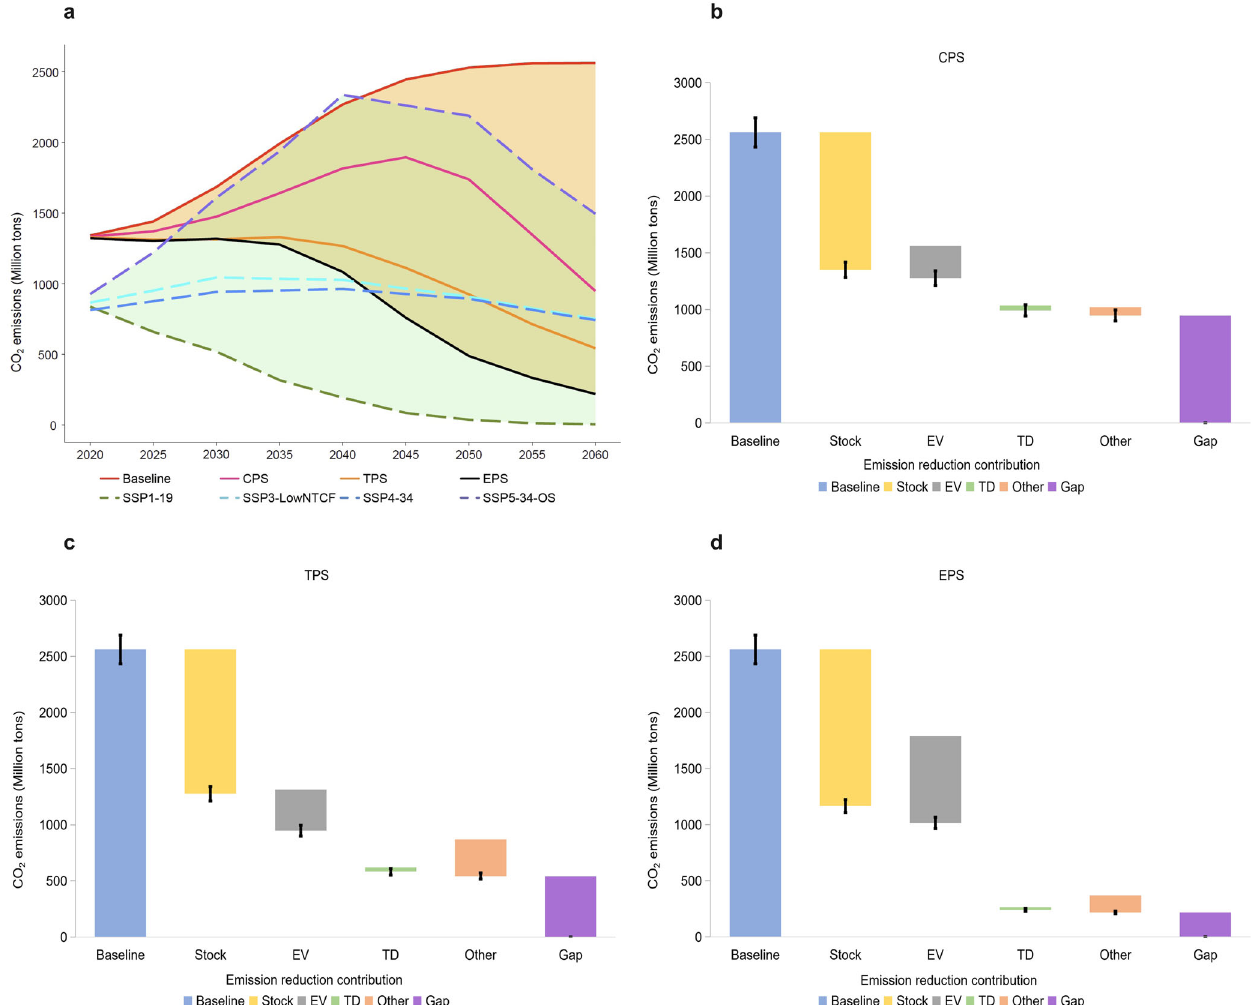
Fig. 5 CO 2 emissions pathways (2020 – 2060) and distribution of carbon mitigation contribution (2060) for China ’ s road transportation. a CO 2 emissions of road transportation across different scenarios (2020 – 2060); b mitigation contribution under the CPS; c under the TPS; d and under the EPS (Stock adjustment = Stock, electri fi cation of vehicles = EV, = TD, Other factors (public transport rate, emission standard control, operation ef fi ciency, etc.) = Other, Zero emissions gap = Gap). ‘ Other ’ includes factors that are not considered in the EV and TD scenarios, such as the increase in the public transportation share, share trips, emission standard control,